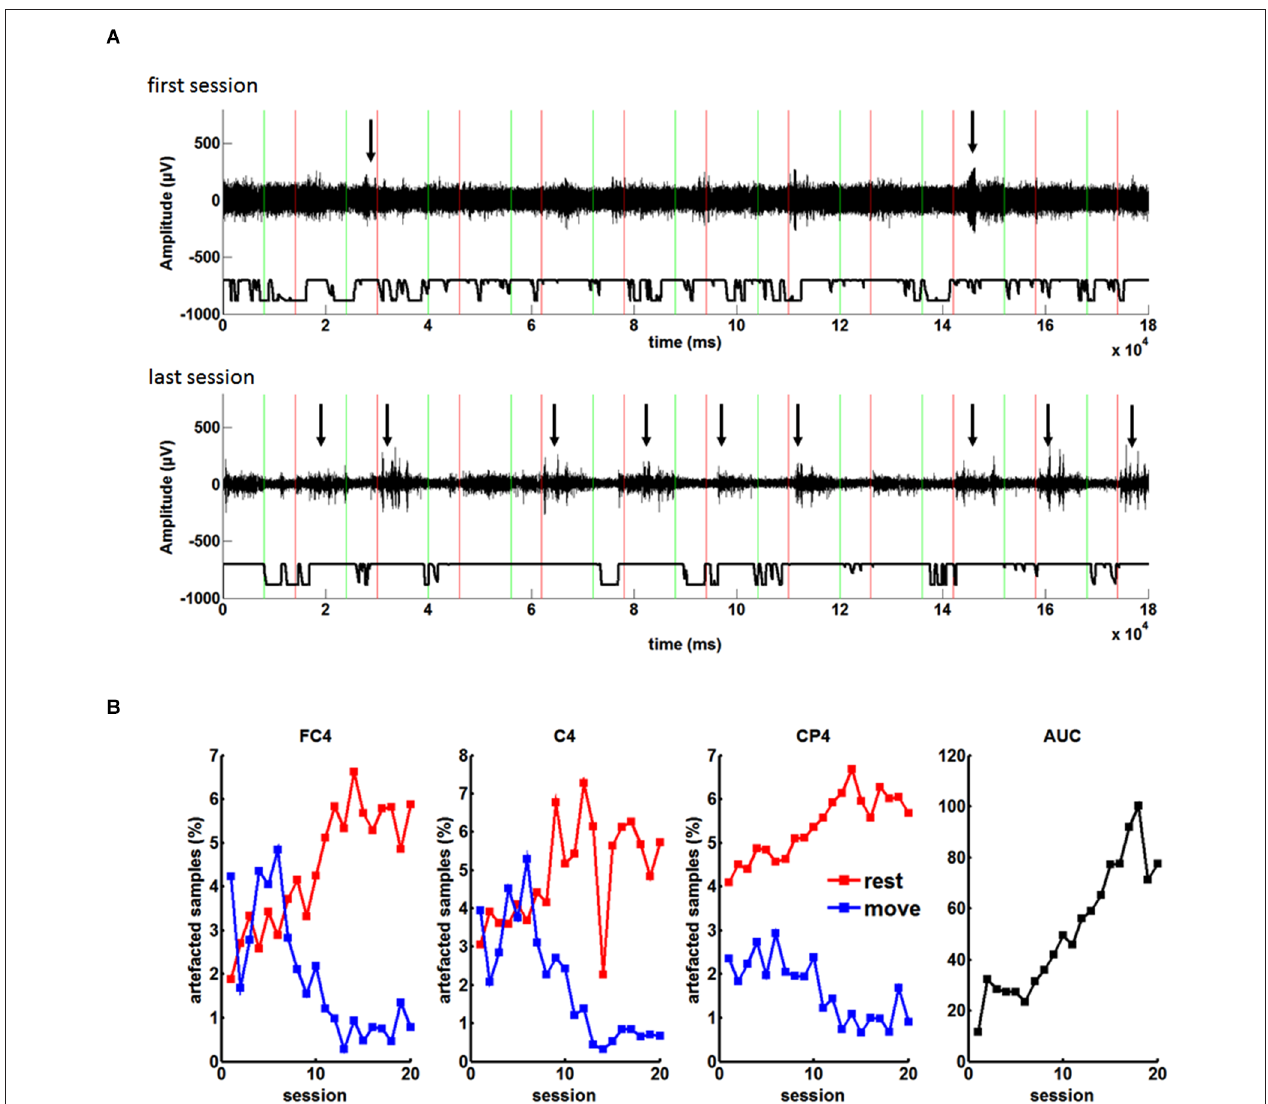
rest and move condition for the three feedback electrodes (FC4, C4, CP4) in the course of twenty sessions. As a result of the increasing difference of artifacts in the rest and the move condition, there was an increase of BCI control measured by the area under the recipient operating characteristics curve